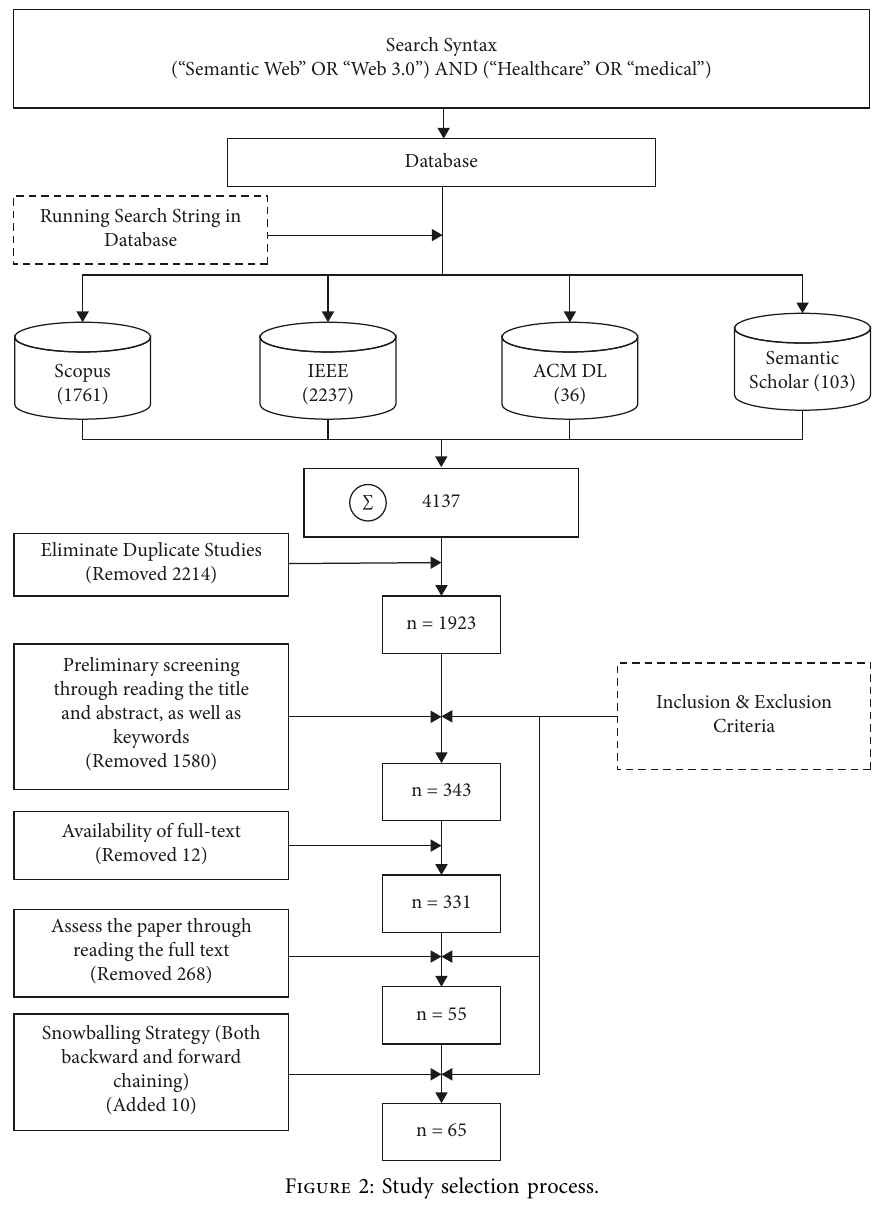
Figure 2: Study selection